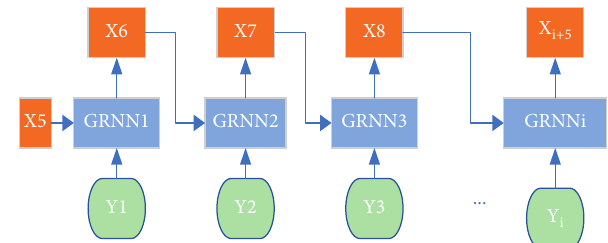
Figure 6: Passenger flow prediction model.